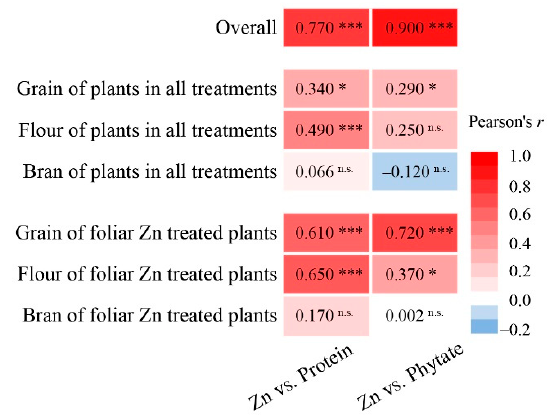
Figure 5. The protein and phytate concentrations in grain, bran, and flour in wheat with nil Zn spray (control) and foliar Zn application alone (Zn) or plus pesticides (P + Zn) in 2017 and 2018. Vertical bars represent the standard error of four replications.